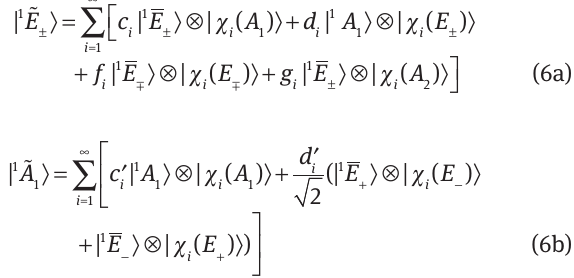
Figure 6: (A) Schematic diagram of APES of typical E ⊗ e linear DJT system along the appropriate configuration coordinate. E Teller energy that separates the total energy at the high symmetry geometry (conical intersection point) and the lowest energy in APES. (B) Calculated HSE06 DFT APES of the NV center in diamond in the electronic 3 E excited state. The barrier energy ( δ with C symmetry breaks the axial symmetry of DJT that can be handled by the so-called quadratic Jahn-Teller Hamiltonian (see Ref. [105]). Q 1 h and Q are the configuration coordinates associated with the effective double degenerate e y